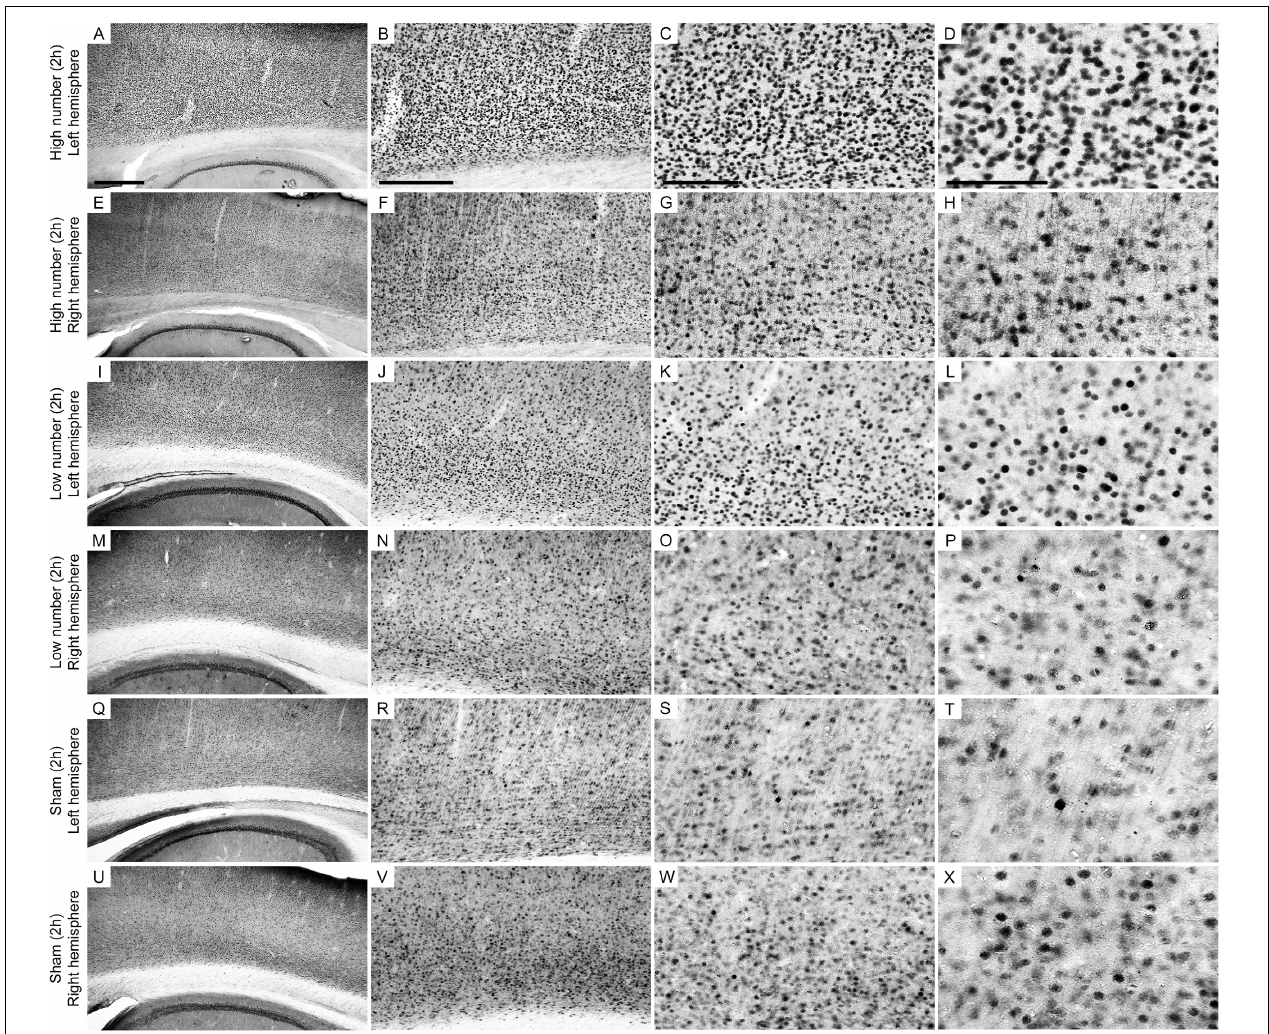
FIGURE 4 | Low-power and high-power photomicrographs of the infragranular somatosensorial (ss) cortical layers in the indicated 2 h recording groups. The sections that were immunolabeled with anti-Egr-1 antibody showed qualitative differences between the 2 h recording groups: high number of CSD episodes in the left/ipsilateral hemisphere (A–D) ; high number of CSD episodes in the right/contralateral hemisphere (E–H) ; low number of CSD episodes in the left/ipsilateral hemisphere (I–L) ; low number of CSD episodes in the right/contralateral hemisphere (M–P) ; sham left/ipsilateral hemisphere (Q–T) ; and sham right/contralateral hemisphere (U–X) . Scale bars in panels (A,E,I,M,Q,U) = 500 µ m; in panels (B,F,J,N,R,V) = 300 µ m; in panels (C,G,K,O,S,W) = 150 µ m; and in panels (D,H,L,P,T,X) = 100 µ